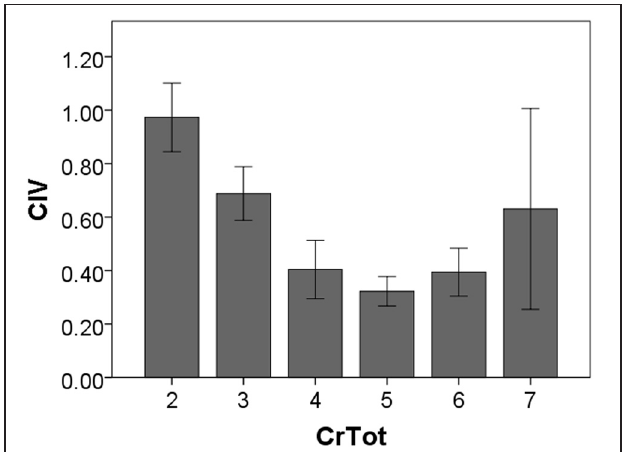
FIGURE 4 | Peak expiratory flow rate (PEFR) for each cough re-acceleration number (Cr N ), categorized according to the total number of cough re-accelerations within the epoch (CrTot).